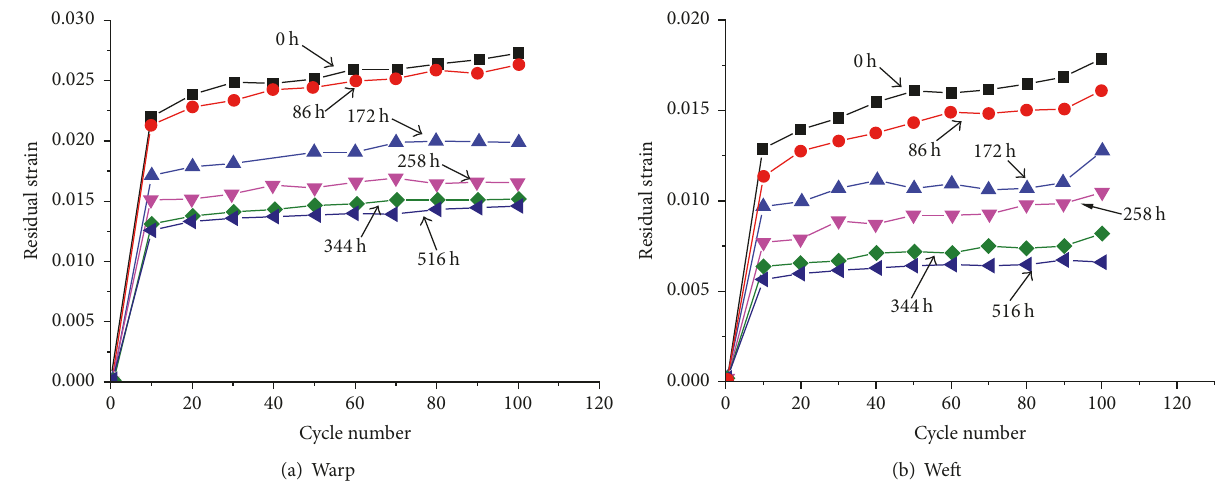
Figure 5: Relationship between cycle number and residual strain after different aging times.